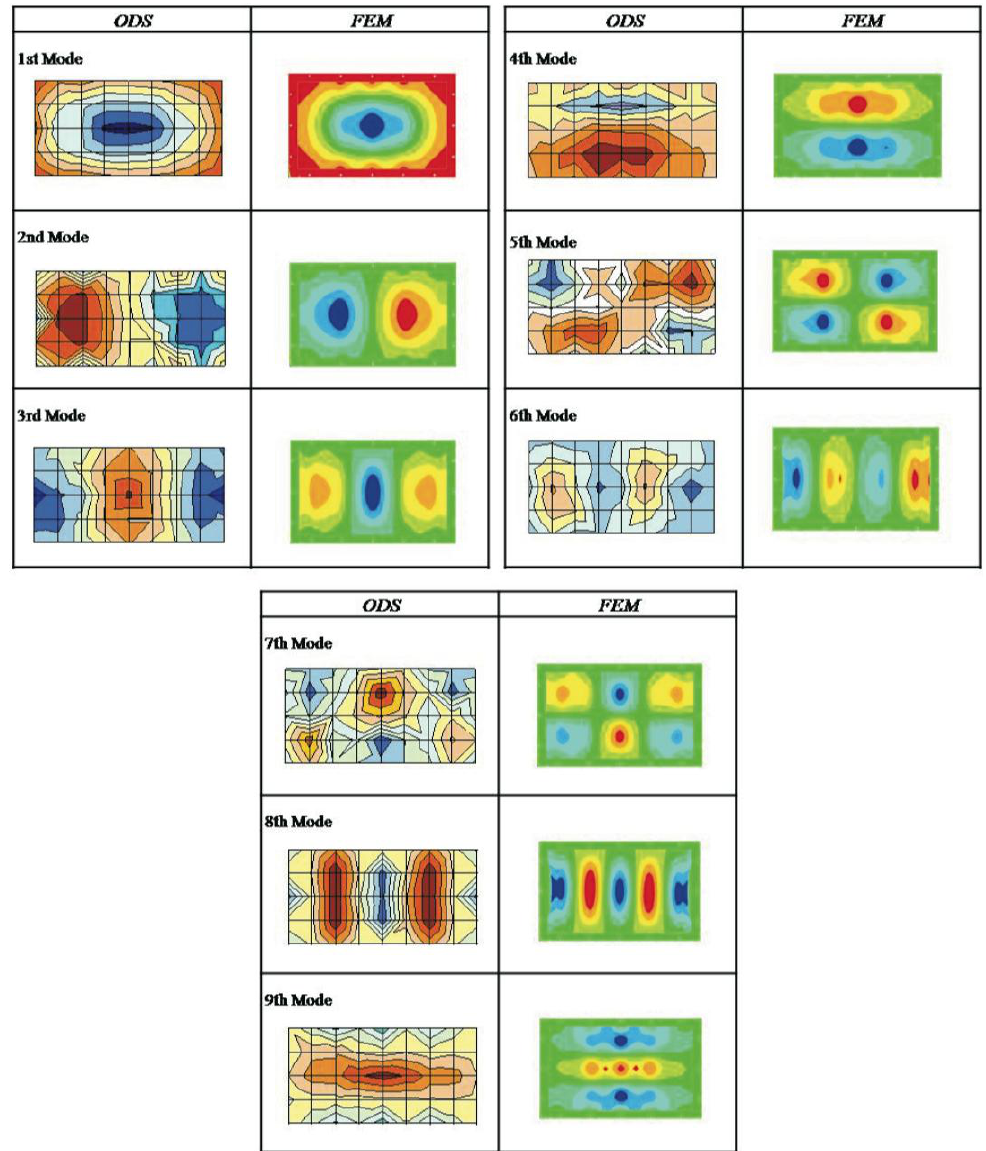
Figure 7. Naked Metal Sheet plus Lightweight Multilayer Composite: ODS ( left ) and Mode Shape (FEM) ( right